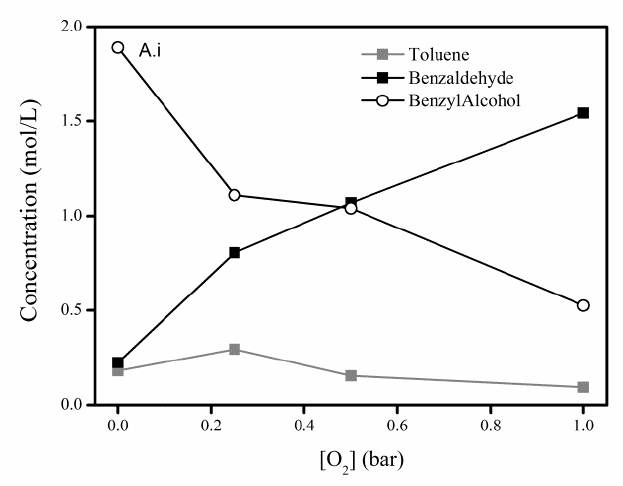
Figure 7. Product concentration as a function of the oxygen pressure. Reprinted with permission from ref. [86]. Copyright 2014, with permission from Wiley.